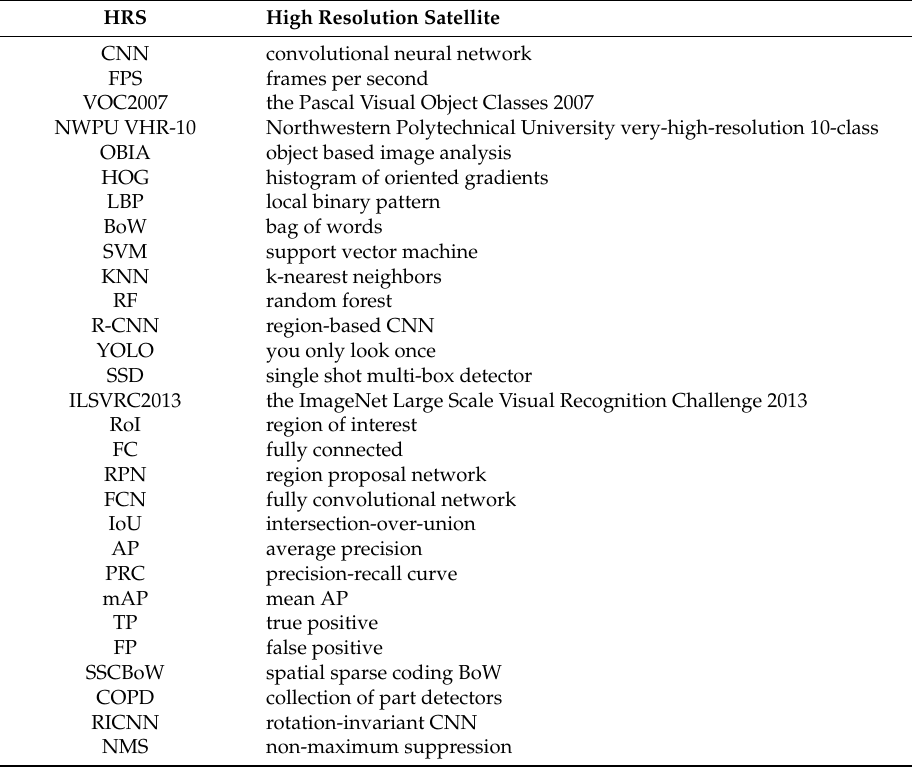
Table 1. Important terms and their